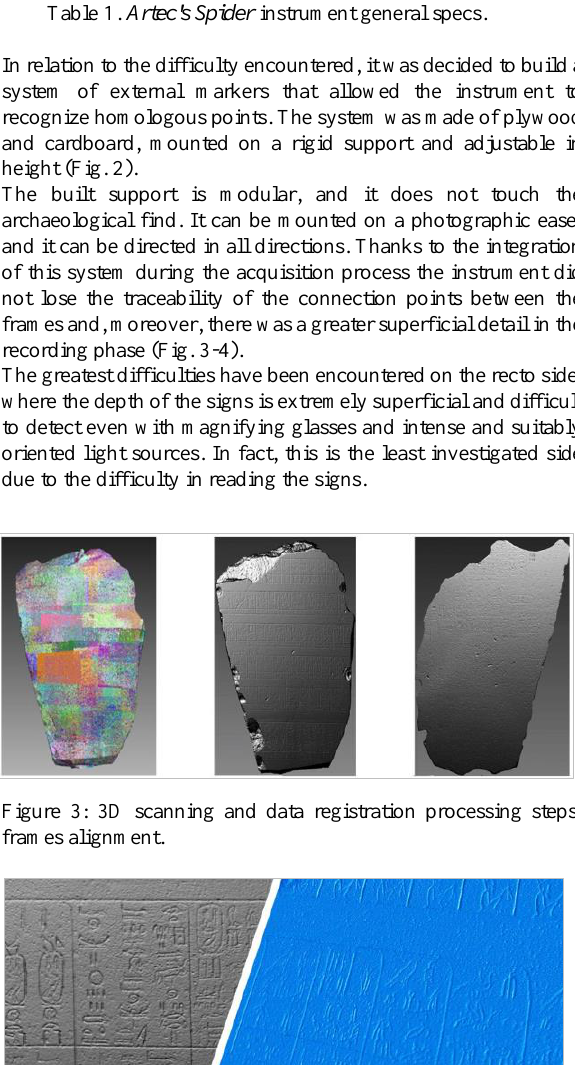
Table 1. Artec's Spider instrument general specs.